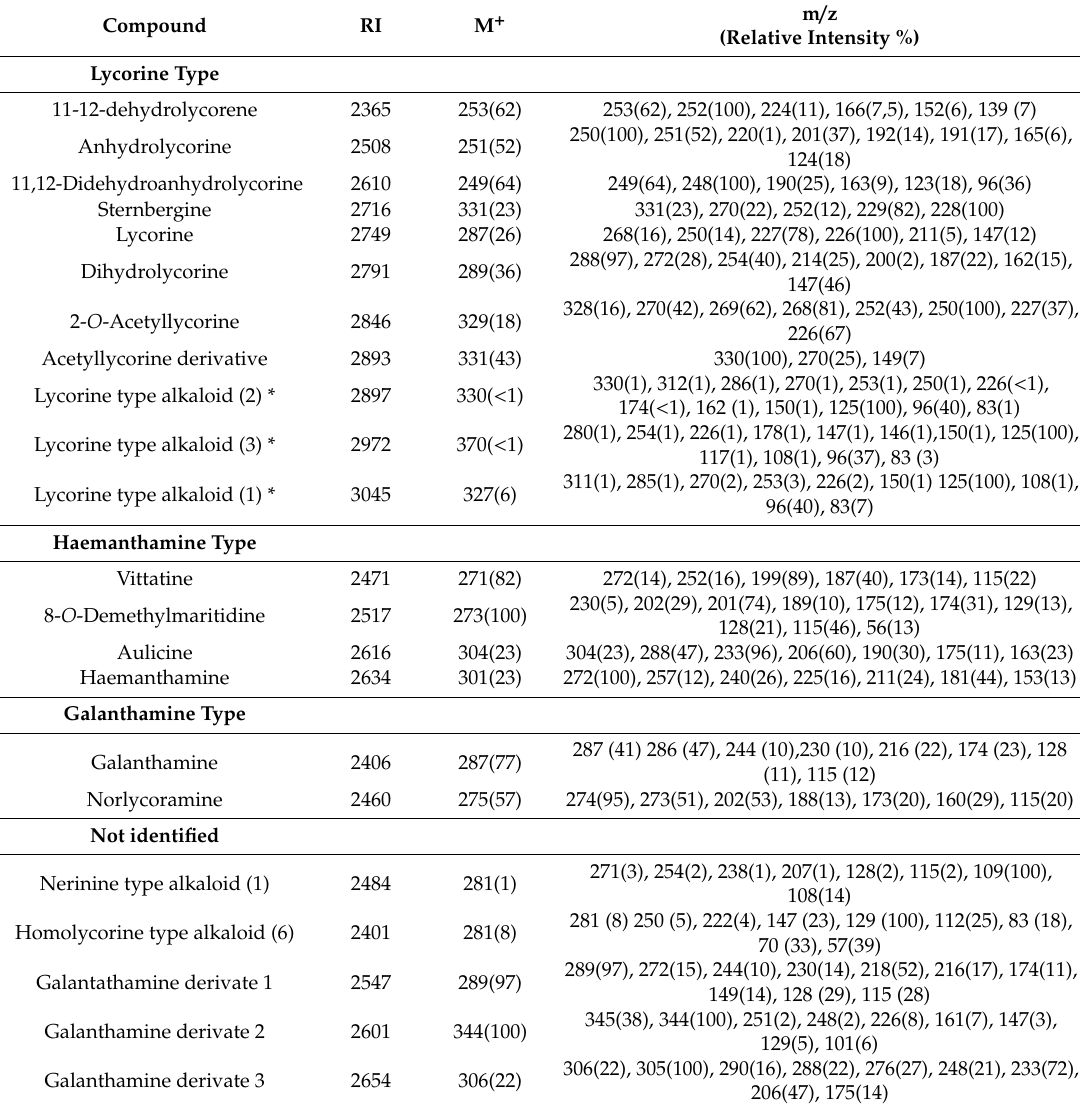
Table 1. GC-MS analysis of the alkaloids from Rhodolirium speciosum